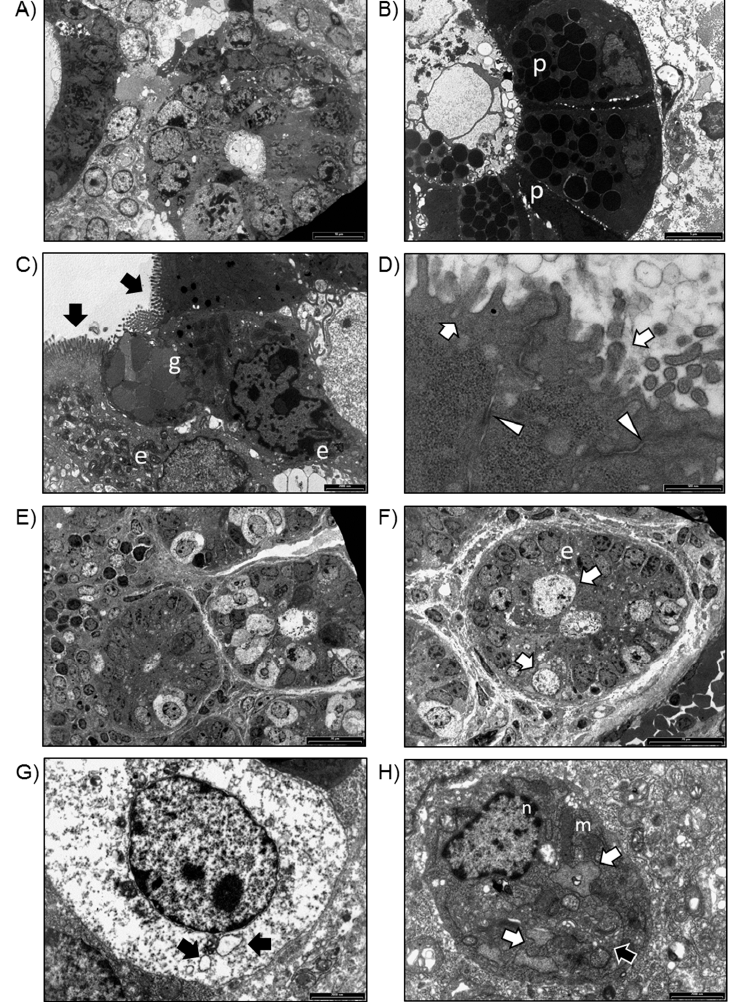
Figure 4. ( A ) TEM analysis of intestinal biopsies isolated from WT mice. Villi in transversal